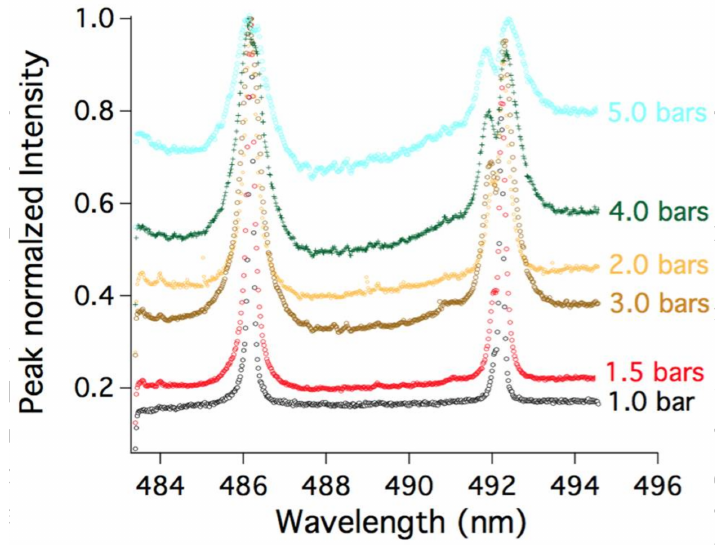
Figure 8. Superposition of six experimental spectra of the He I 492 nm ( right peak ) and H- β 486.2 nm ( left peak ) lines measured at room temperature for pressures in the range 1–5 bars. Black: 1 bar, red: 1.5 bars, light brown: 2 bars, dark brown: 3 bars, green: 4 bars, and blue: 5